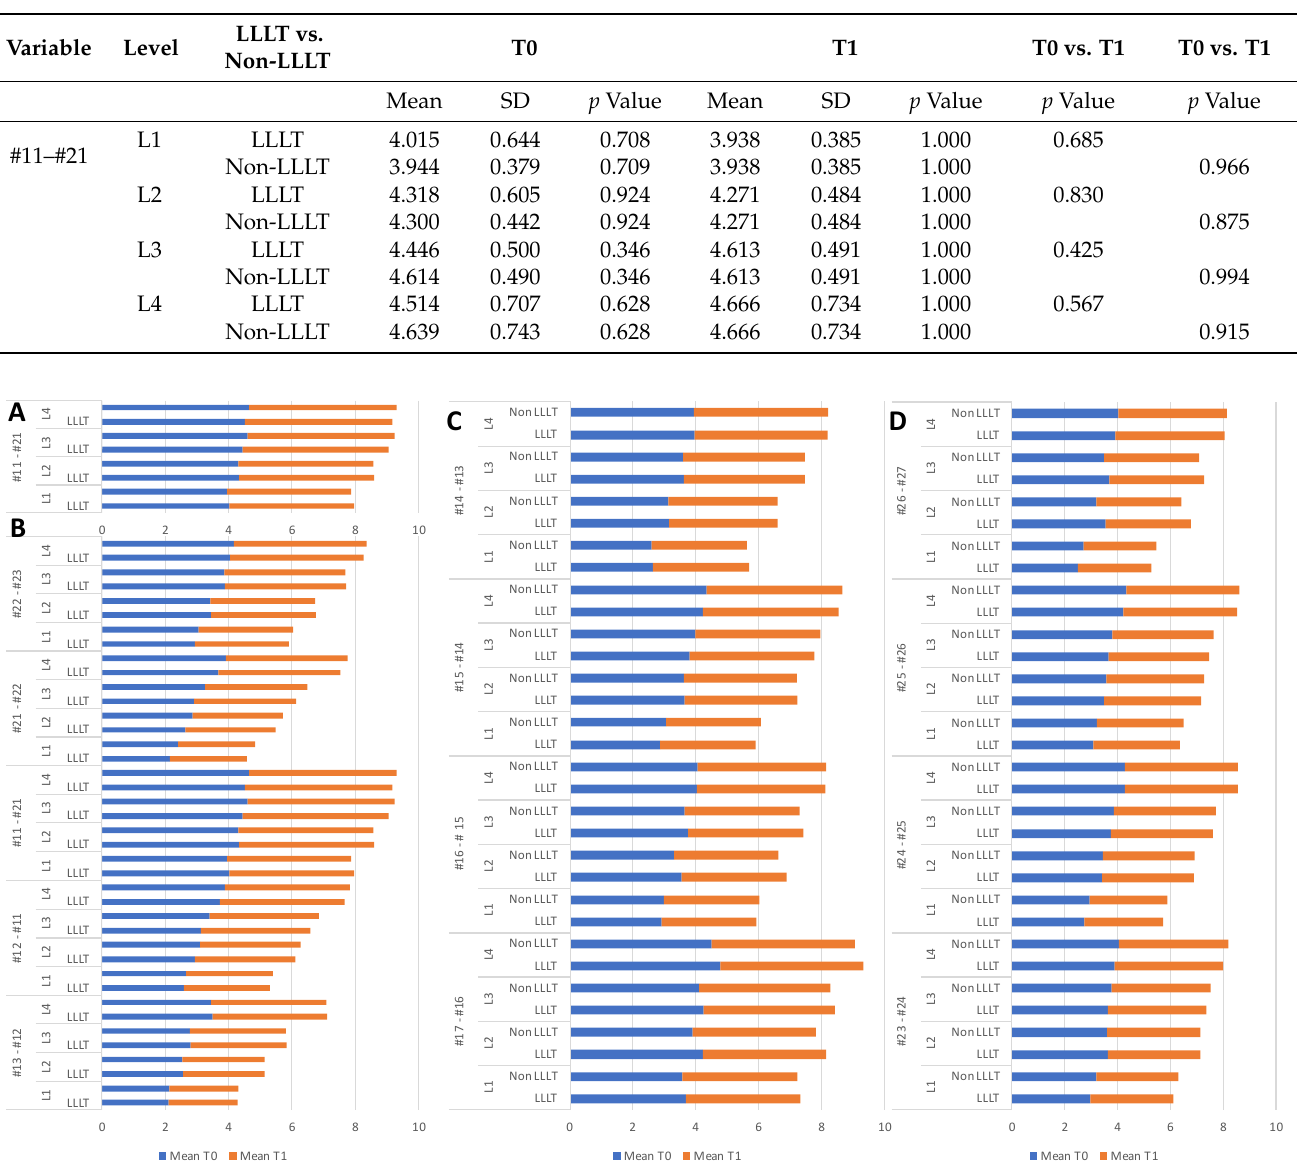
Table 1. IRW of the maxilla (both sides) at various levels. LLLT and non-LLLT differences between pre- and post-treatment groups—middle quadrant teeth.